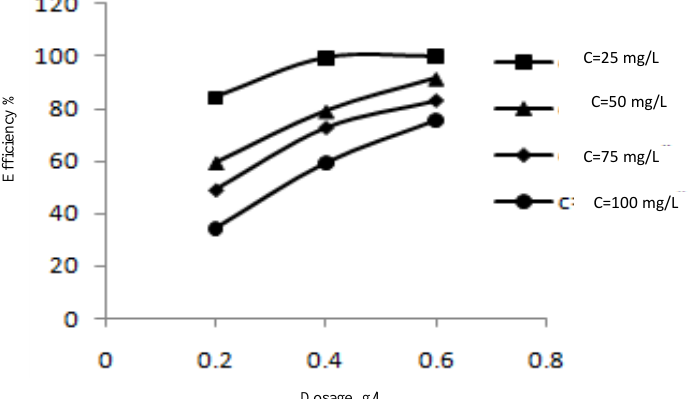
Figure 6. Effect of adsorbent dosage on the adsorption of AR18 in different dye concentration (contact time =120 min, pH= 3, T=25 o